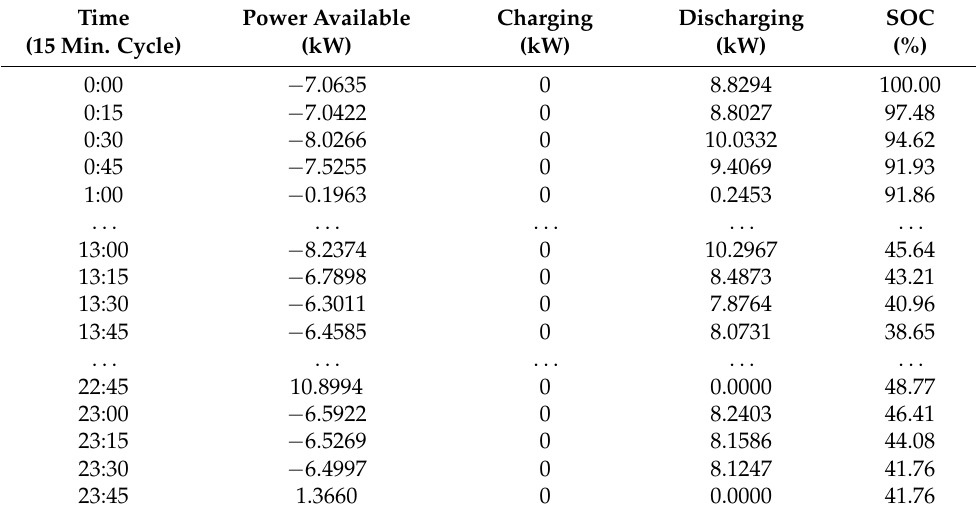
Figure 21. State of charge of Street Battery in CSPVND. Table 11. Power available, Charging, Discharging and SOC values in CSPVPD. Time Power